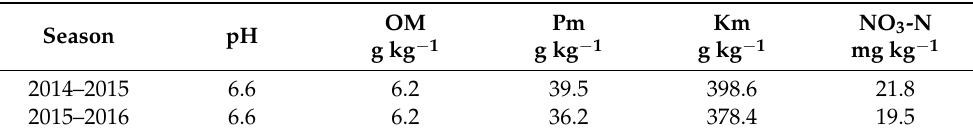
Figure 1. Daily rainfall (PP), maximum and minimum temperature (T ◦ Max, T ◦ Min) at experimental station “El Nogal” in Chill á n, Chile. Table 1. Initial soil analysis for experimental sites in Chill á n, Ñuble, Chile in the 2014 to 2015 and 2015 to 2016 growing